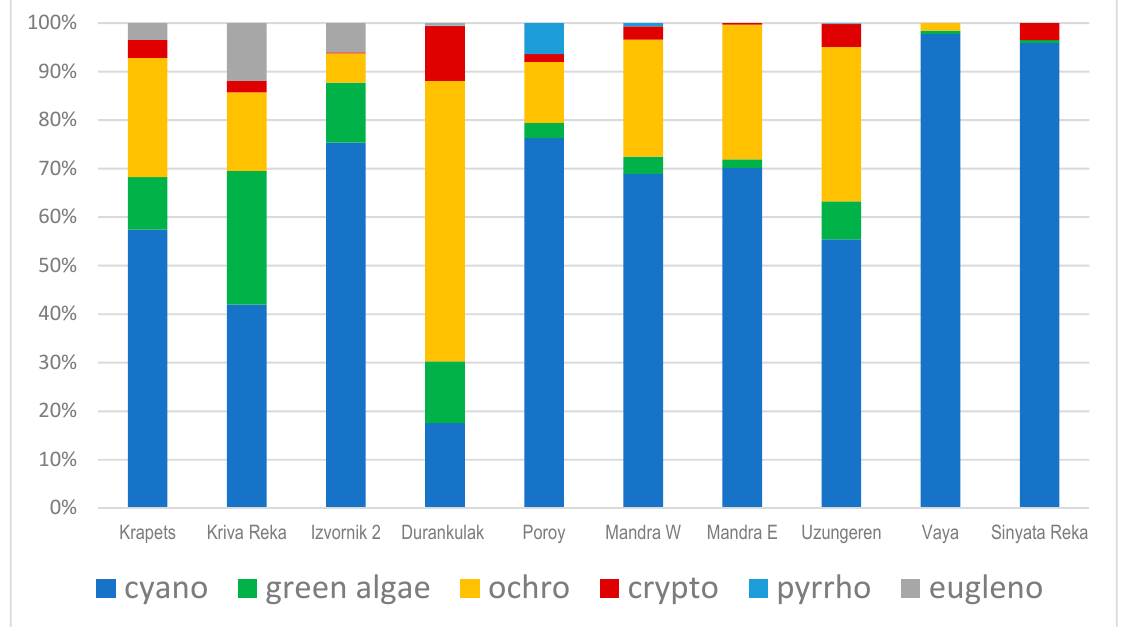
Figure 6. General phytoplankton composition according to the pigment markers analyzed by HPLC (expressed as per- centage contribution to chlorophyll a , calculated using CHEMTAX) in the studied Bulgarian water bodies (August 2019). Legend: Mandra W—western part of the reservoir Mandra, Mandra E—eastern part of the reservoir Mandra; cyano— cyanoprokaryotes, green algae—chlorophytes and streptophytes, ochro—ochrophyta (incl. diatoms and golden algae), crypto—cryptophytes, pyrrho—pyrrhophytes and eugleno—euglenophytes. The values of chlorophyll a , measured by HPLC, ranged from 0.9 to 856 µ g L − 1 .